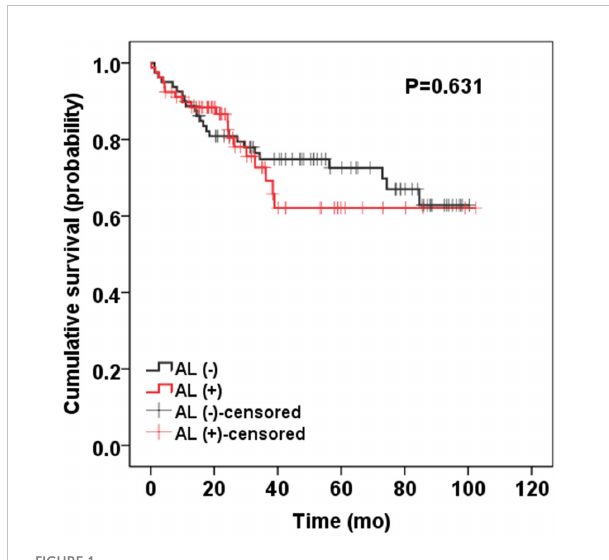
FIGURE 1 Kaplan – Meier curve presenting the overall survival